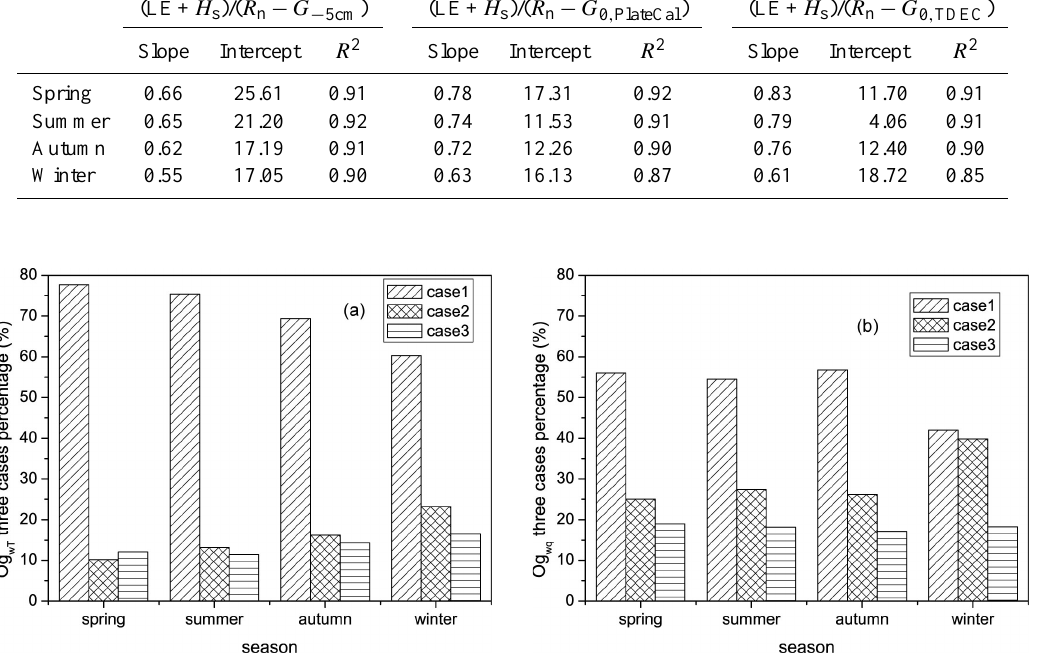
Fig. 10. Seasonal distribution of Ogive function analysis for three cases for (a) sensible (Og wT ) and (b) latent (Og wq ) heat flux from SACOL data at the SACOL